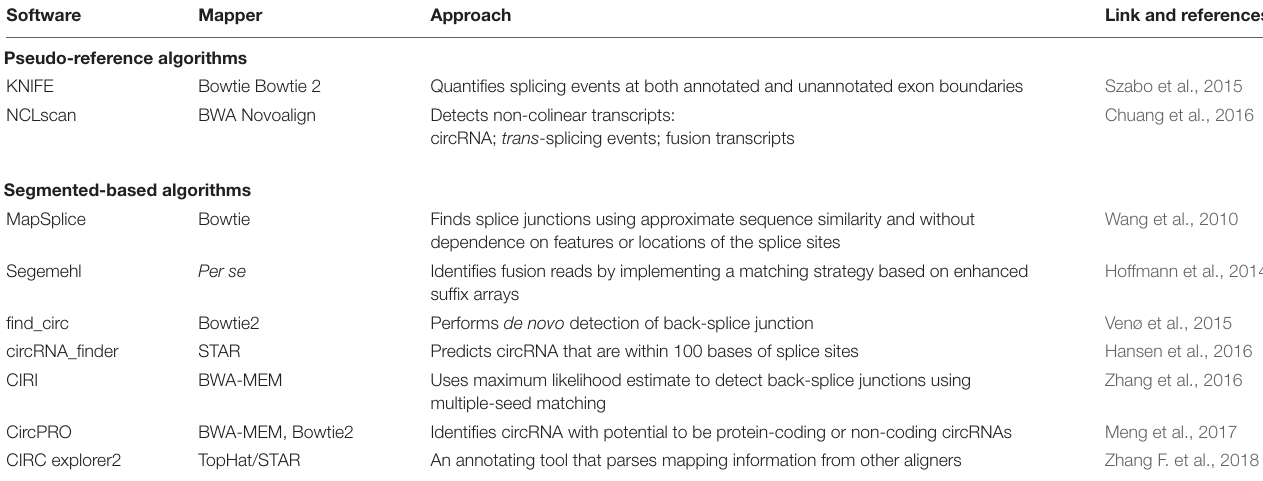
TABLE 1 | Overview of the most common algorithms used to detect circular RNAs from RNA sequencing data. Software